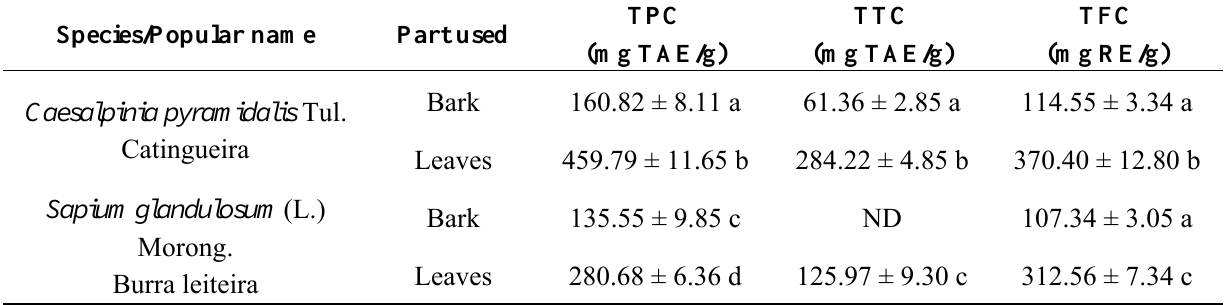
Table 1. Total phenolic content (TPC), total tannin content (TTC) and total flavonoid content (TFC) of Caesalpinia pyramidalis Tul. and Sapium glandulosum (L.)